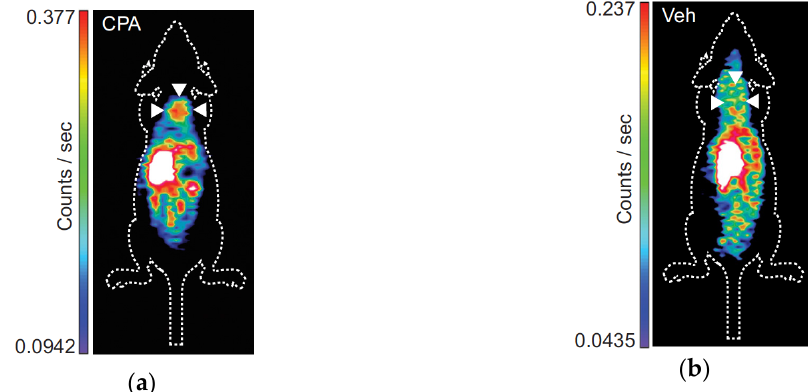
Figure 5. [ 18 F]ICMT-11 PET images of 38C13 xenograft-bearing mice: ( a ) Treated with CPA; ( b ) Treated with vehicle.